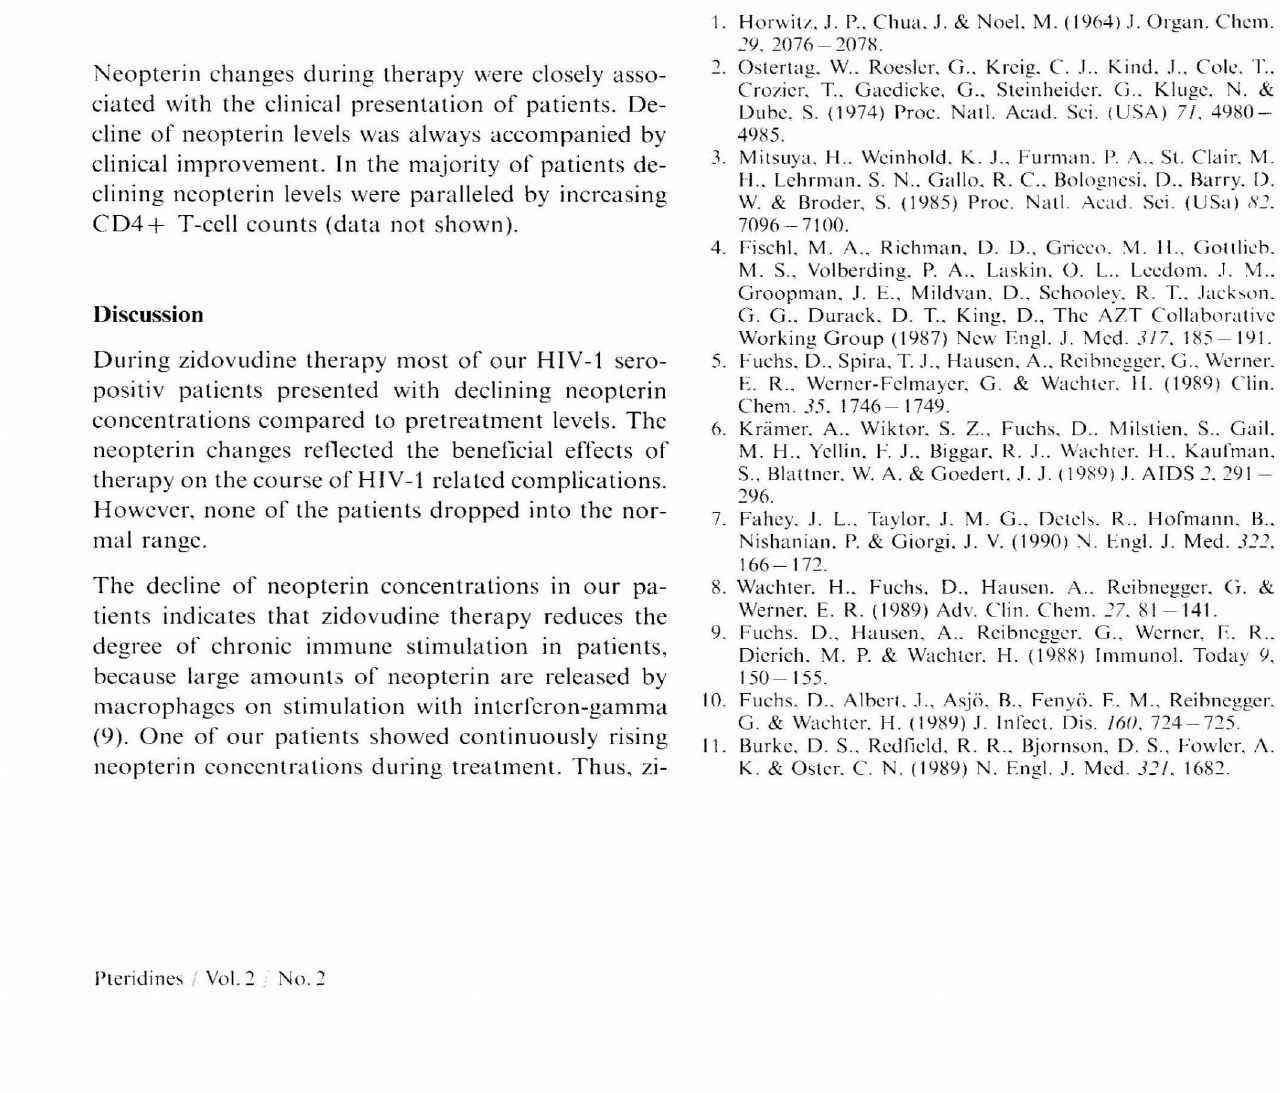
Table 1. Urinary neoptcrin conccntrations (llmo\imol creati ninc) before and during treatmcnt with zidovudine of 14 HIV I seropositives (median and 25th- 75th perccntile are shown)